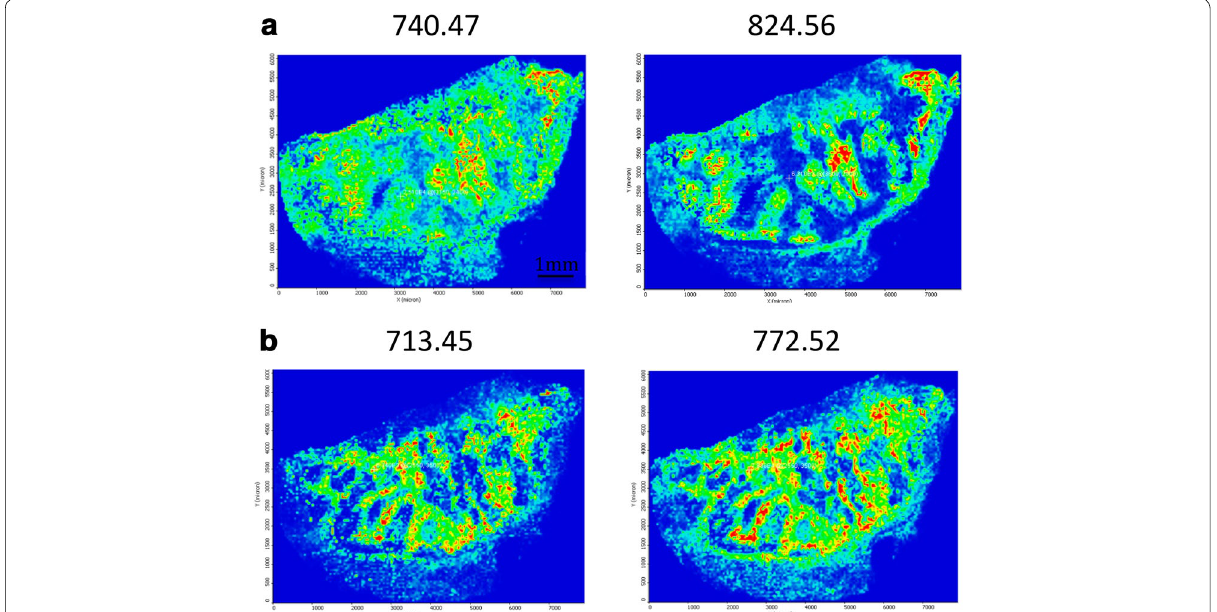
Fig. 4 MALDI images from melanoma tissue samples isolated after surgery. Metabolites were detected in melanoma and lymphocyte compartments. The scale bar represents 1